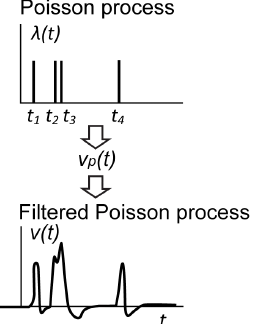
Figure 5. Output signal of SiPM as a filtered Poisson